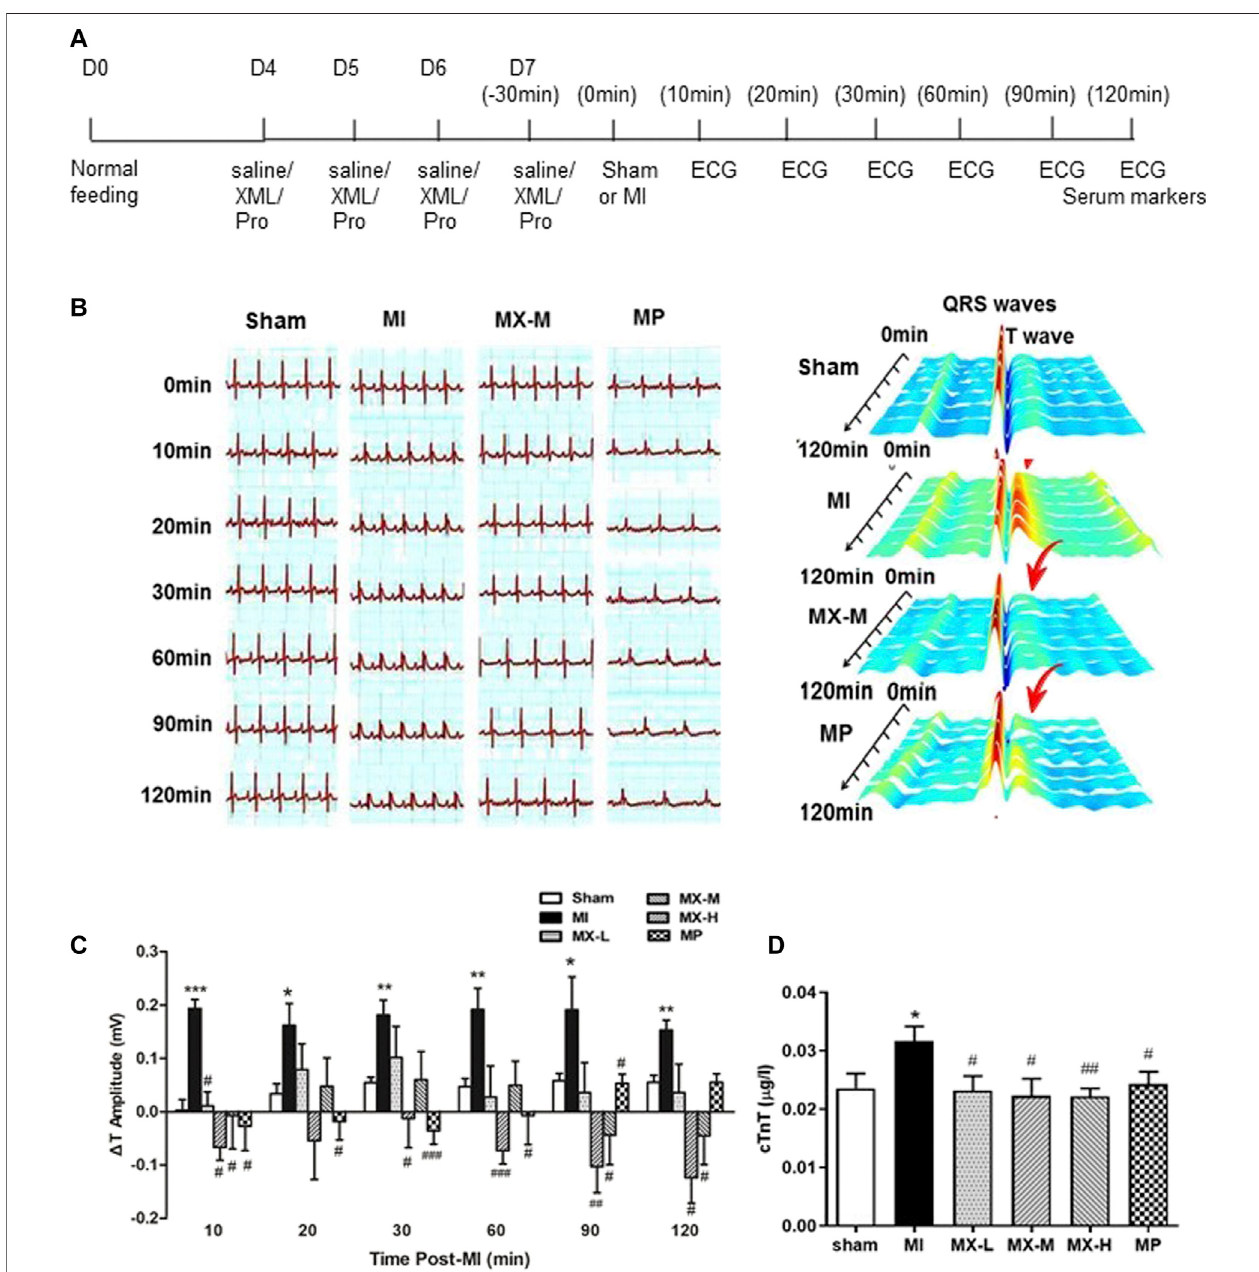
FIGURE 2 | Protective effect of XML on myocardial ischemia induced by ligation of the left anterior descending coronary artery in the rat. (A) Timeline of drug administration. Rats received a pretreatment with normal saline ( n = 4) or XML injection (low dose — L ( n = 5), medium dose — M ( n = 6), high dose — H ( n = 5)), or propranolol (10 mg/kg) ( n = 6) for a total of 4 days. The left anterior descending coronary artery of rats was ligated 30 min after the fi nal administration to induce the myocardialischemiamodel.Heartcontractilefunctionwasassessedbythenoninvasivecardiacimagingtechnologyofechocardiography(ECG)andmeasurement of serum cardiac troponin T (cTnT) biomarker levels. (B) Electrocardiogram recordings of SD rats. (C) T interval ofthe rats in each group. (D) cTnT levels for each group. Asterisk(*)refers tostatisticalsigni fi cance incomparisonswiththe CONgroup (* p < 0.05,** p < 0.01, *** p < 0.005), while #referstocomparisons withtheMIgroup ( # p < 0.05, ## p < 0.01, ### p < 0.005).